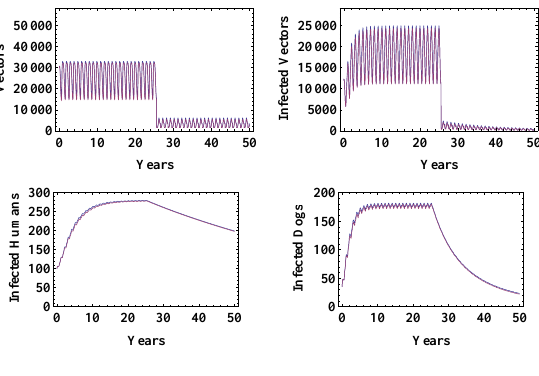
Fig. 9. Model behavior with τ 1 = τ 2